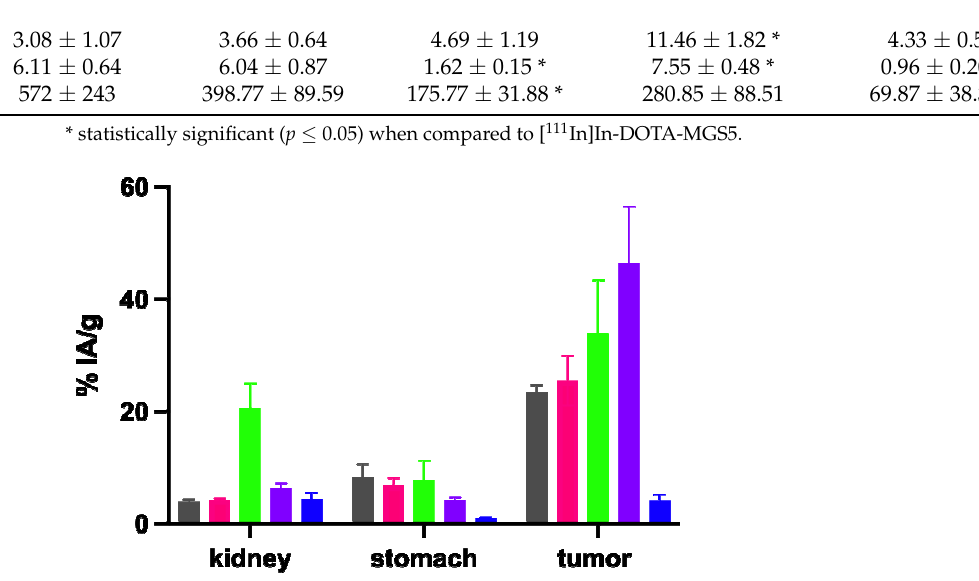
Figure 4. Uptake in kidney, stomach and A431-CCK2R xenografts at 4 h p.i. of the 111 In-labeled pep- tides in comparison with [ 111 In]In-DOTA-MGS5 [19]. Gray: DOTA-MGS5, pink: DOTA-[2Nal 8 ]MGS5, green: DOTA-[DLys 1 ]MGS5, purple: DOTA-[( N -Me)1Nal 8 ]MGS5, blue: DOTA-MGS5[NHCH 3 ].